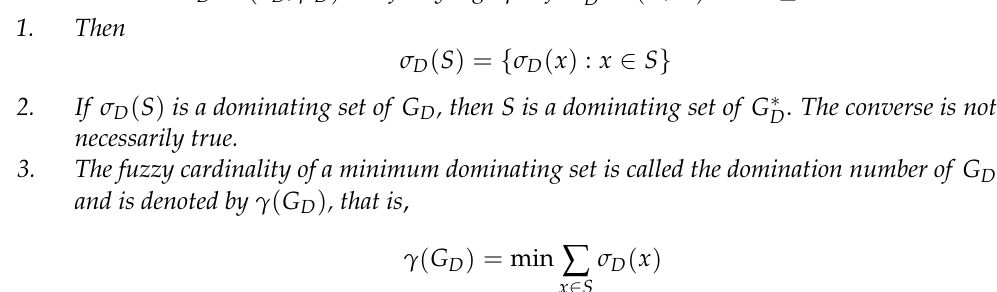
is σ D = { σ D ( a ) , σ D ( b ) , σ D ( c ) , σ D ( d ) } D